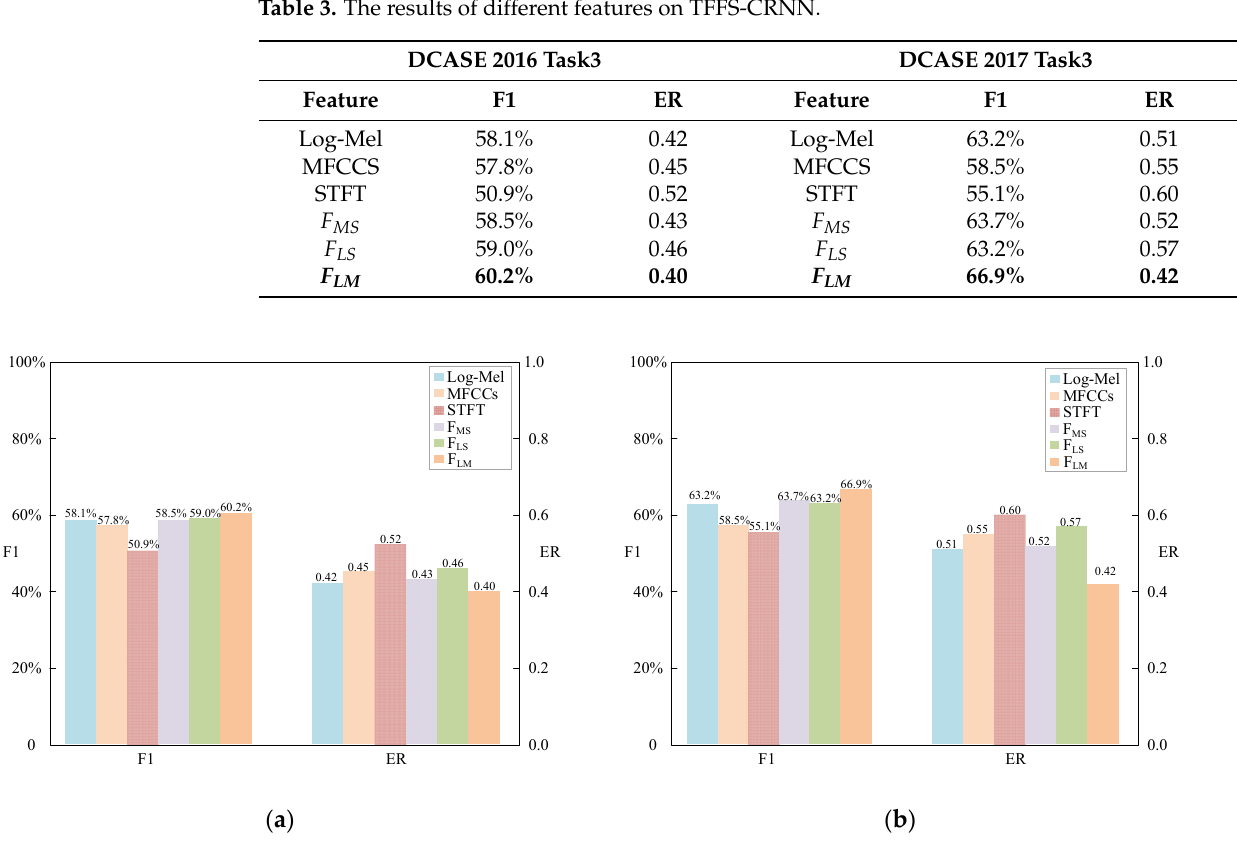
Figure 5. The results of different features on TFFS-CRNN in the evaluation dataset. The vertical coordinate of each bar in different colors represents ER and F1 of the model, respectively. The figure ( a ) is the experimental result of the DCASE 2016 Task3 dataset; the figure ( b ) is the experimental result of the DCASE 2017 Task3 dataset. Table 3. The results of different features on TFFS-CRNN.